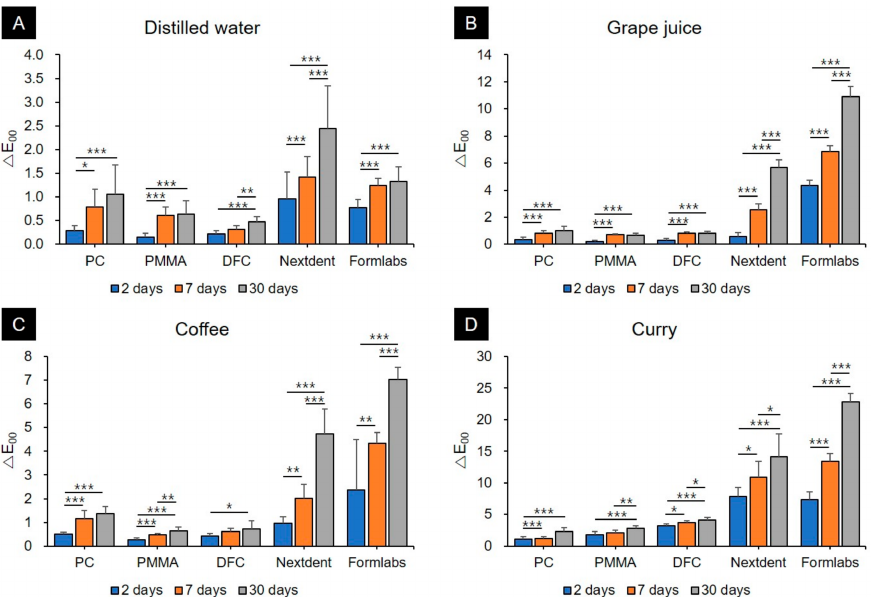
Figure 3. Graphs showing the di ff erences in changes of color tones according to the type of colorant used (mean + standard deviation). ( A ) Distilled water, ( B ) Grape juice, ( C ) Co ff ee, ( D ) Curry. In each graph, the asterisk (*) represents a p -value ≤ 0.05, the double (**) asterisk represents a p -value ≤ 0.01 and the triple (***) asterisk represents a p -value ≤